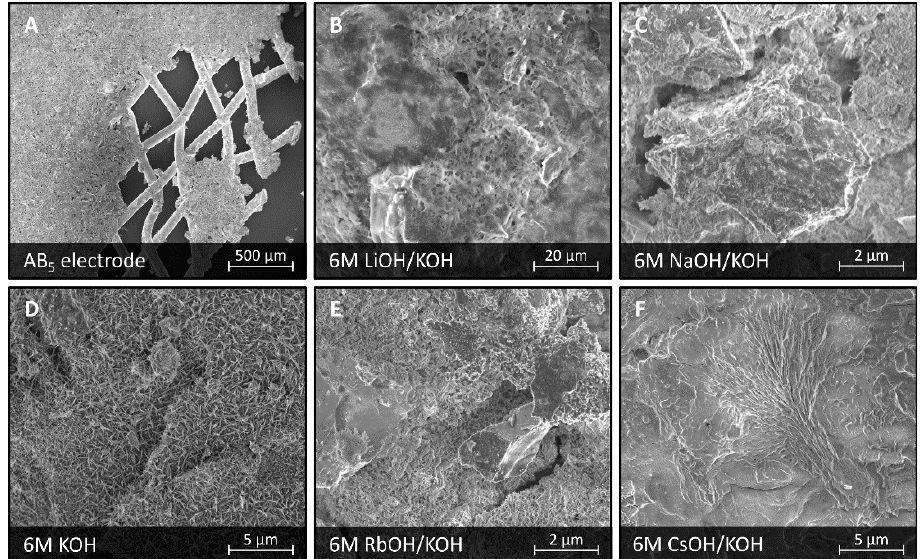
Figure 4. SEM images of a surface of LaMm-Ni 4.1 Al 0.3 Mn 0.4 Co 0.45 alloy not subjected to any treatment ( A ), and after electrochemical treatment at 6 M electrolytes: 6 M LiOH/KOH ( B ), 6 M NaOH/KOH ( C ), 6 M KOH ( D ), 6 M RbOH/KOH ( E ), and 6 M CsOH/KOH ( F ).